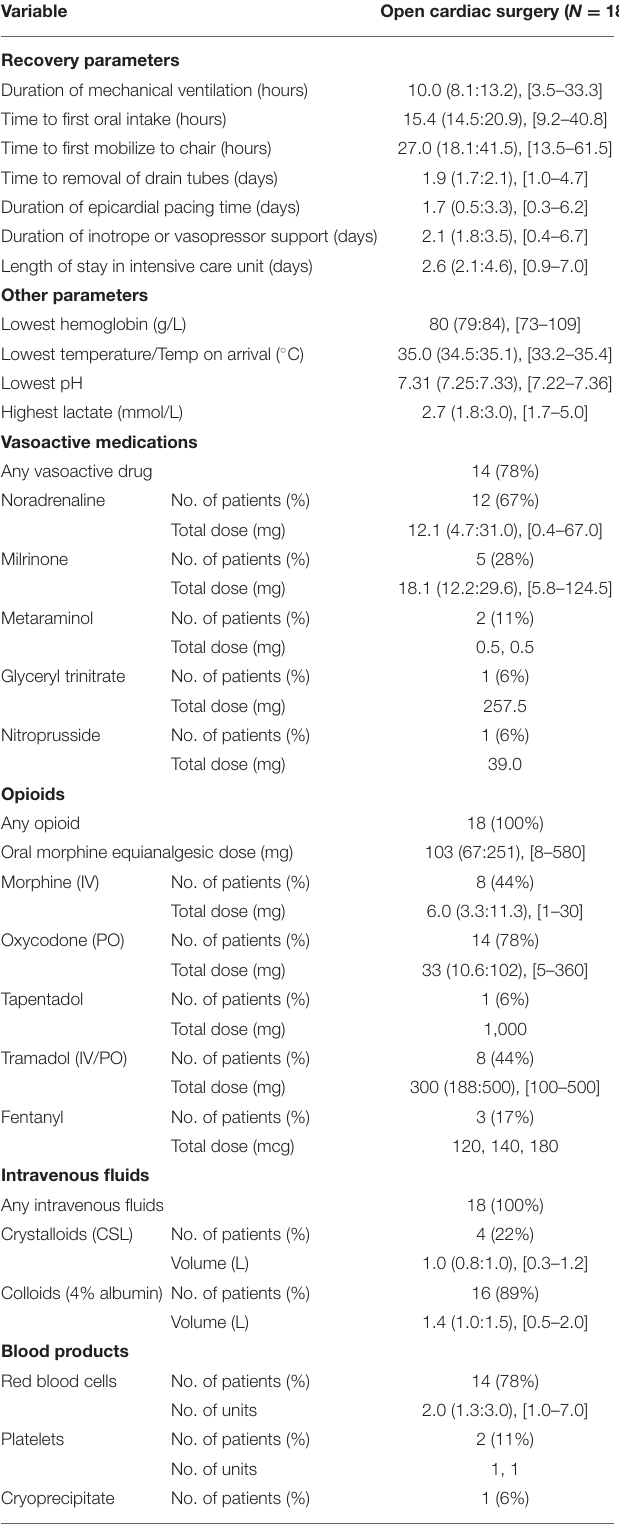
TABLE 6 | Postoperative management of nonagenarians undergoing open cardiac surgery.